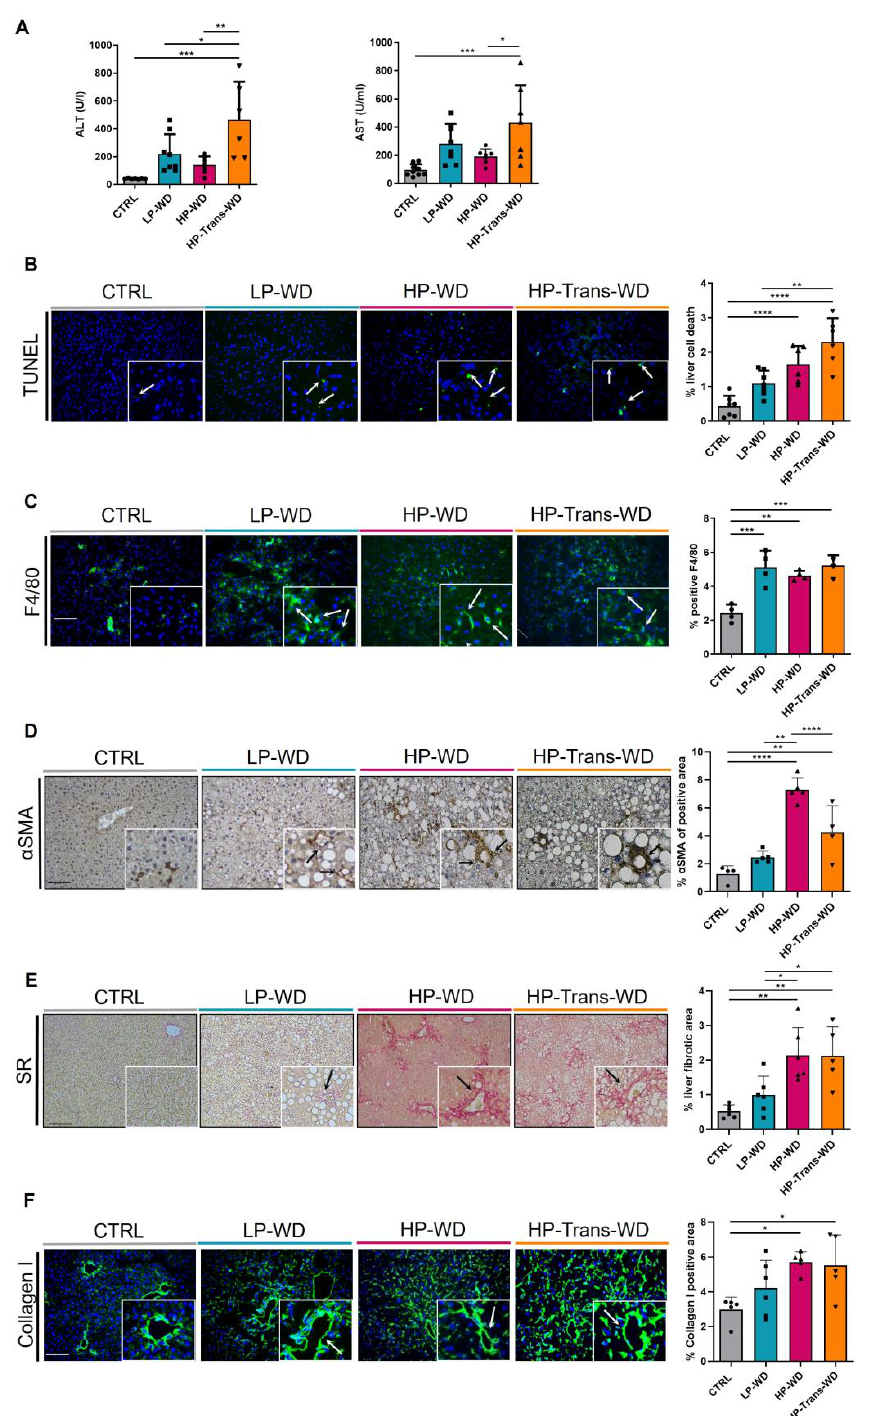
Figure 5. Hepatitis and hepatic fibrosis in mice on the WD for 14 weeks. ( A ) ALT and AST measure- ments in serum after 12 h of fasting (n = 7–9). ( B ) Representative TUNEL-stained photomicrographs at 14 weeks. Scale bar = 100 µ m. Quantification of % TUNEL positive cells (n = 6–7). ( C ) F4/80 IF staining in liver sections of mice fed for 14 weeks. Positive immune cells are stained in green. Nuclei are stained in blue using DAPI as a counterstain. Arrows indicate F4/80 positive cells, respectively. Scale = 100 µ m. Quantification of % F4/80 positive cells, using ImageJ software (n = 4). ( D – F ) Fibrosis-related stainings in liver and corresponding quantification of positive stained areas after 14 weeks of treatment. Representative liver images stained with α -SMA (IHC) ( D ), SR ( E ), Collagen I (IF) ( F ). Scale bar = 100 μm. (n = 4 – 7). * for p < 0.05, ** p < 0.01, *** p < 0.001; **** p < 0.0001.